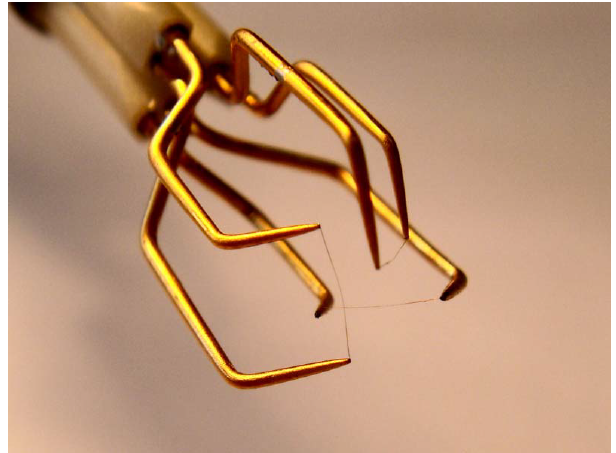
Figure 8. The triaxial Dantec 55R91 hot-wire probe.